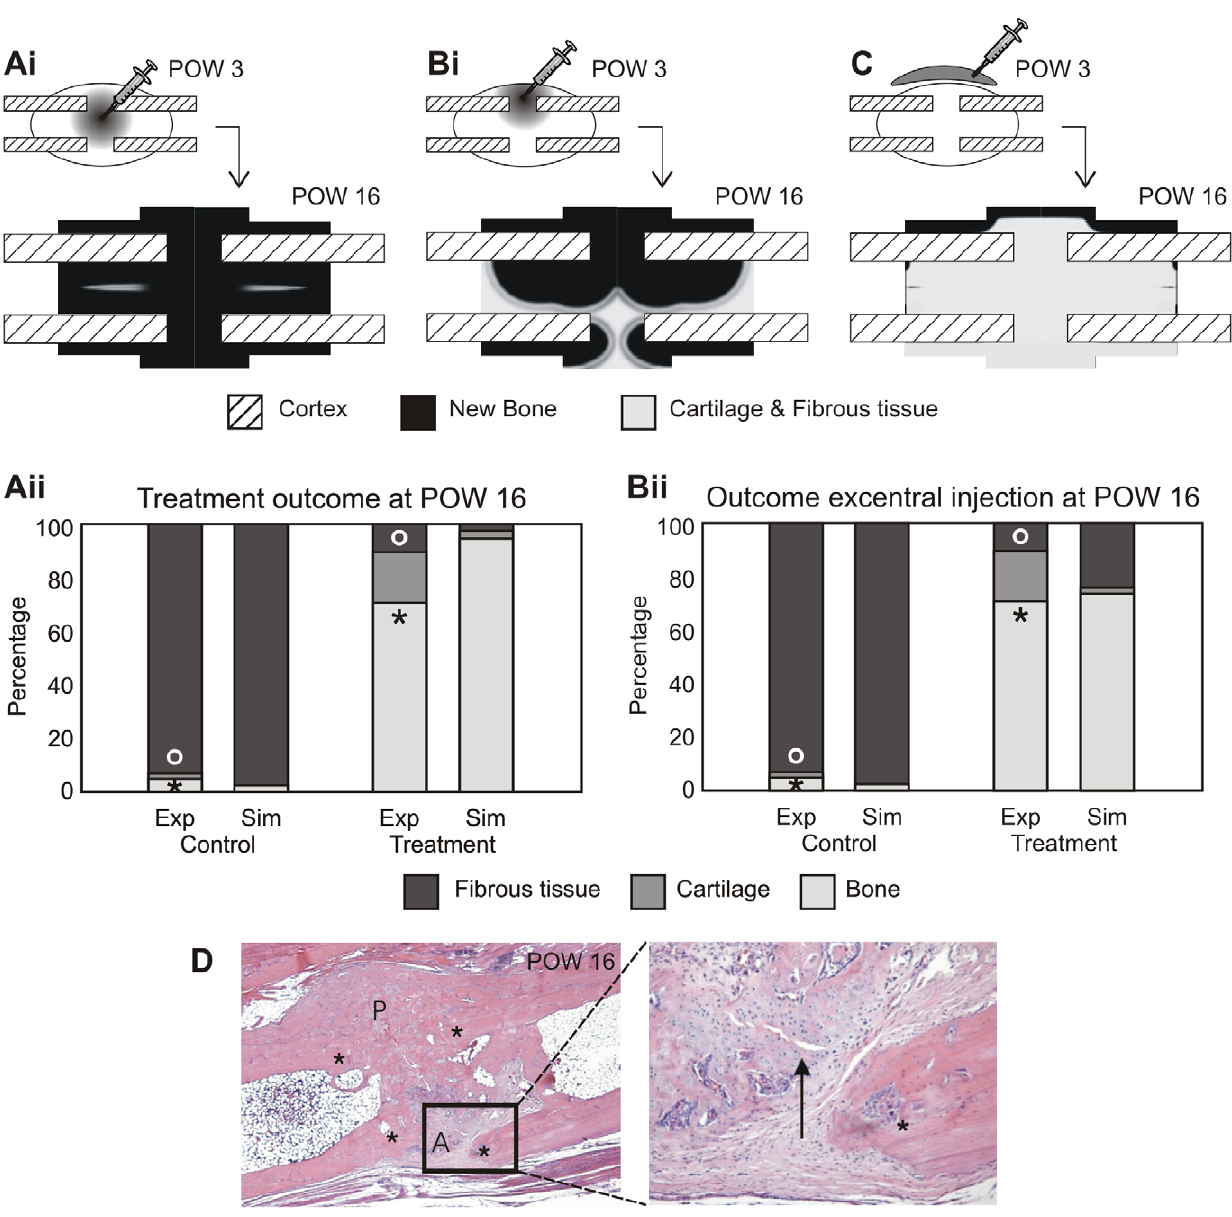
Figure 5. The effects of MSC transplantation on atrophic non-union. ( Ai ) Simulation results for the treatment with the cell transplant injected in the centre of the callus. ( Aii ) A comparison of experimentally measured (Exp) and numerically calculated (Sim) tissue constituents present within the interfragmentary gap of control (carrier solution injected) and treatment (MSC transplant) groups ( o * p , 0.005, students t-test). Simulation results are shown for a central injection of the carrier solution. ( Bi ) Simulation results for the treatment with the cell transplant injected excentrally in the callus. ( Bii ) A comparison of experimentally measured (Exp) and numerically calculated (Sim) tissue constituents present within the interfragmentary gap of control (carrier solution injected) and treatment (MSC transplant) groups ( o * p , 0.005, students t-test). Simulation results are shown for an excentral injection of the carrier solution. ( C ) Simulation results for the treatment with the cell transplant injected outside the callus. ( D ) Histological section (H&E) showing full bony callus bridging of the posterior (P) aspect of the tibia but no bony bridging at the anterior (A) aspect. Original bone ends marked *. An area of endochondral ossification (arrow) is present at the anterior aspect of the tibia. Images taken at 6 20